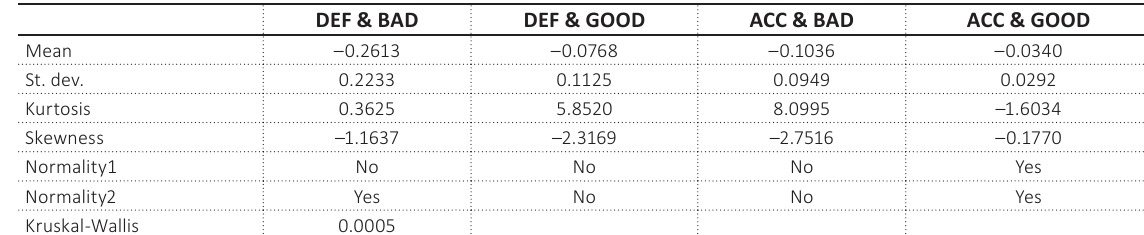
Table 5. All cases, CAR7